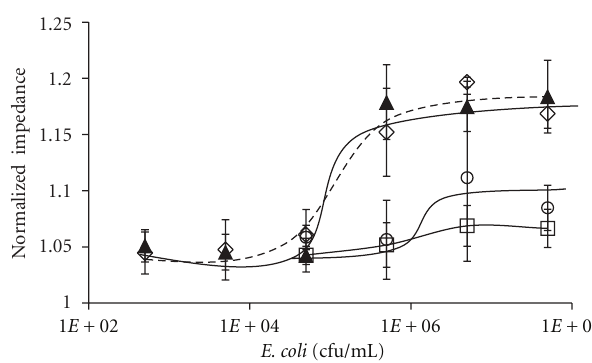
Figure 4: Comparison of CNT-FET antibody coating procedures. Increasing concentrations of E. coli O157:H7 were added to E. coli O157:H7 polyclonal antibody immobilized onto CNT-FET circuits using either EDC/NHS ( (cid:2) ), Pyrenebutyric acid succinimide ester ( ◦ ), Pyrene hydrazide modified antibody ( (cid:3) ) or pyrenebutanoic acid/ pyrenebutanoic acid succinimide ester at a molar ratio of 3:1 ( ♦ , dotted line) as described in Section 2. Impedance was measured for 4 minutes after addition of the bacteria and plotted as the normalized value compared to the baseline of the individual circuit. Each point represents at least 5 measurements with standard error of the